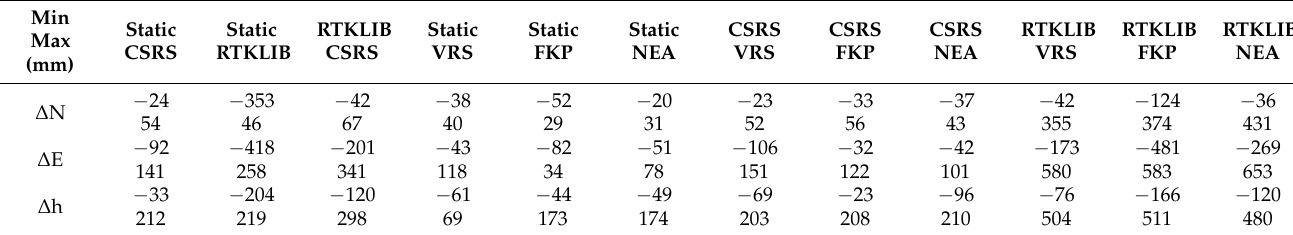
Table 3. Range of variability minima – maxima values, min – max (mm), for ∆ N, ∆ E and ∆ h differences, post removal of the extreme